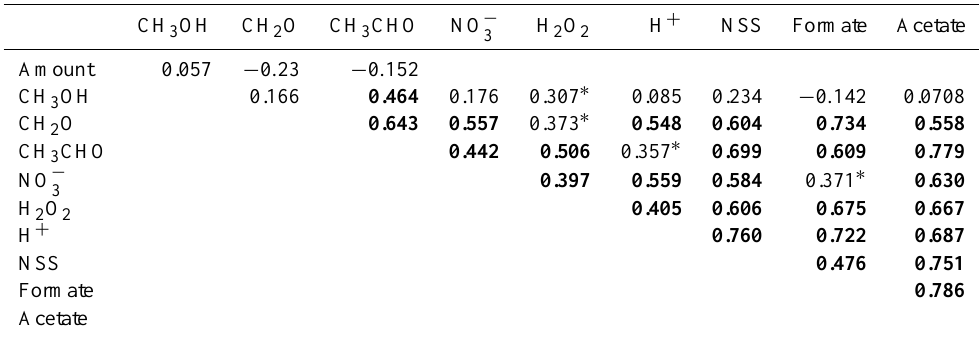
Table 1. Intercorrelations among methanol, formaldehyde, acetaldehyde, and various other rainwater components. Bold-faced values indicate significance at p < 0 . 001. Asterisk ( ∗ ) indicates significance at p < 0 . 05. Number of samples equals 47 for acetaldehyde, nitrate, and sulfate, 27 for formate and acetate, and 49 for